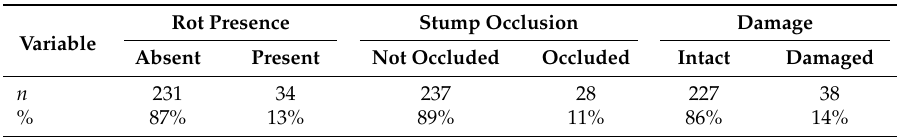
Table 1. Summary of the field-defined tree-stump classes in terms of number of tree-stumps ( n ) and percentage of the total number (%).